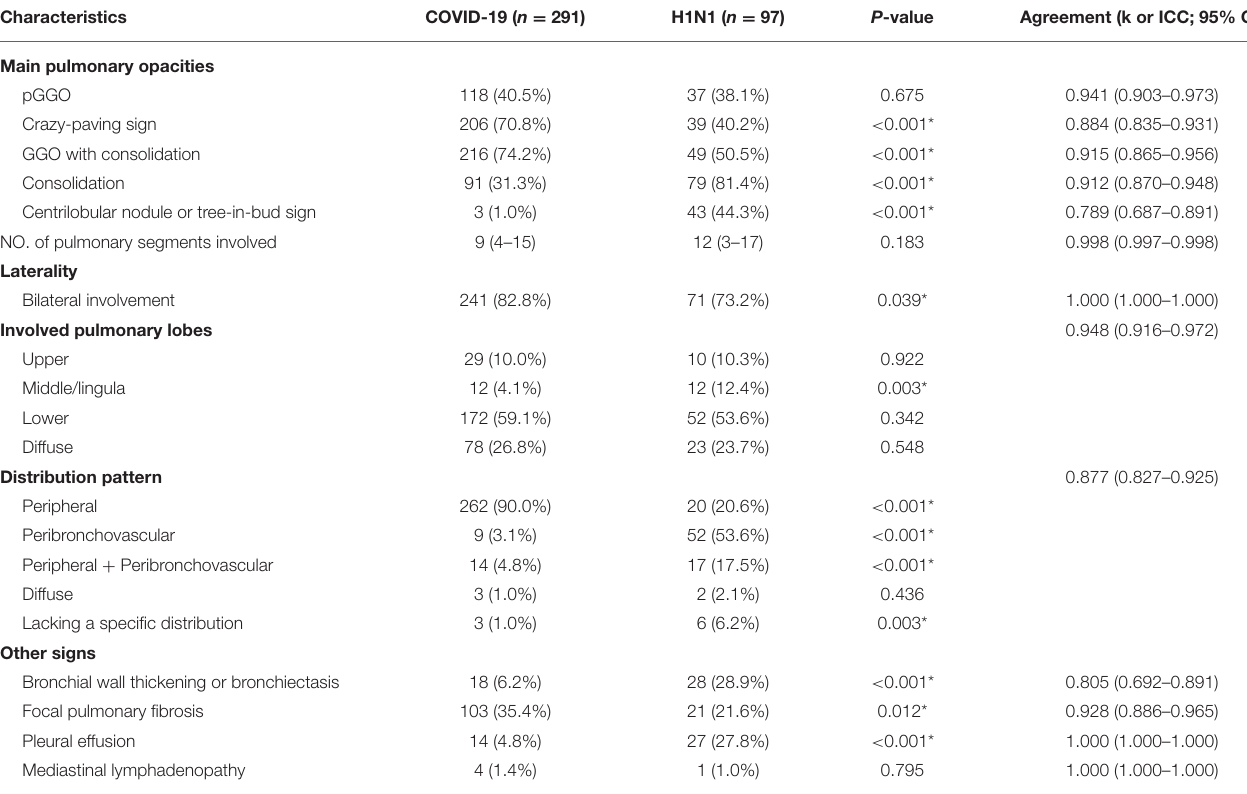
TABLE 2 | Baseline CT characteristics of the patients with COVID-19 pneumonia vs. those with H1N1 pneumonia.